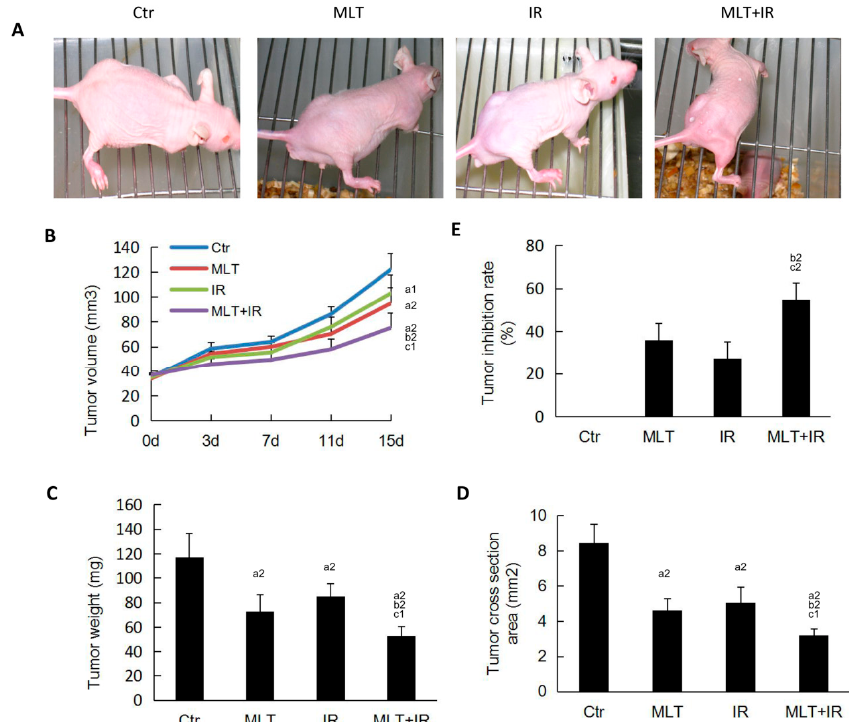
Figure 5. Melatonin suppressed tumor growth in nude mice exposed to γ -ray radiation. ( A ) The effect of melatonin and/or IR on tumorigenicity was examined in nude mice. Mice were treated with melatonin, IR, or a combination of melatonin and IR when tumor volume reached 40 mm 3 . Photographs of the tumor-bearing mice are displayed; ( B ) tumor growth curve was determined; ( C ) tumor weight was examined after mice were sacrificed at 15 days; ( D ) tumor sections were stained with H.E. and tumor cross-section area was calculated after mice were sacrificed at 15 days. (E) Tumor inhibition rate of xenografts at day 15 was analyzed. Tumor inhibition rate = (Weight control group – Weight treated group )/Weight control group × 100%. Data are presented as the mean ± SD. a1 p < 0.05; a2 p < 0.01 vs. control, b2 p < 0.01 vs. IR, c1 p < 0.05; c2 p < 0.01 vs. MLT.